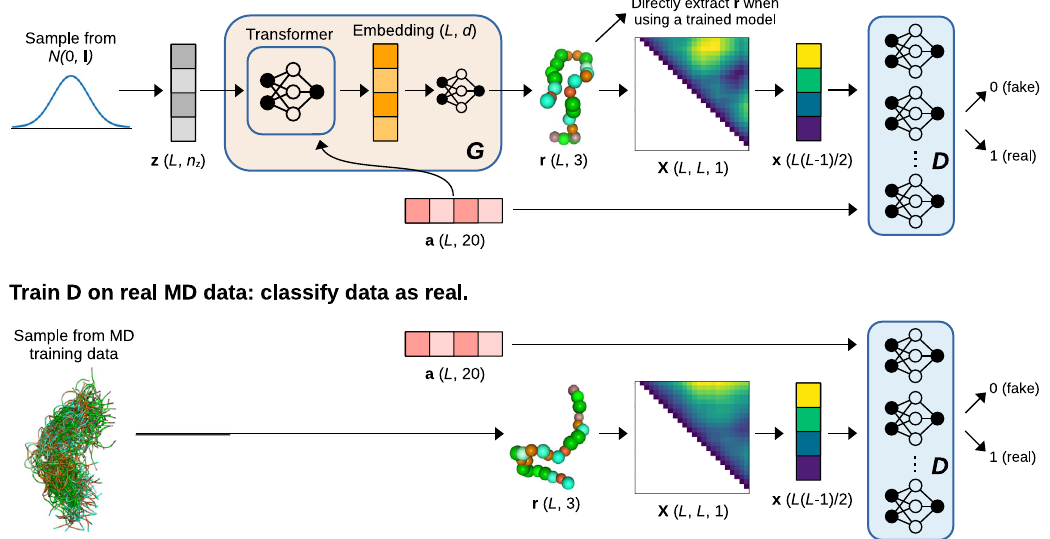
Fig.1|OverviewoftheidpGANnetworkarchitecture. A z latentsequenceisused asinput to the G network. Amino acid information a isalso provided asinput to G. The output of the last transformer block of G is mapped to 3D Cartesian coordi- nates r through a position-wise fully-connected network. Conformations r from G andthetrainingsetareconvertedindistancematricesandtheiruppertrianglesare used as input to asetofD networks, whichalso receive asinput a .The objective of